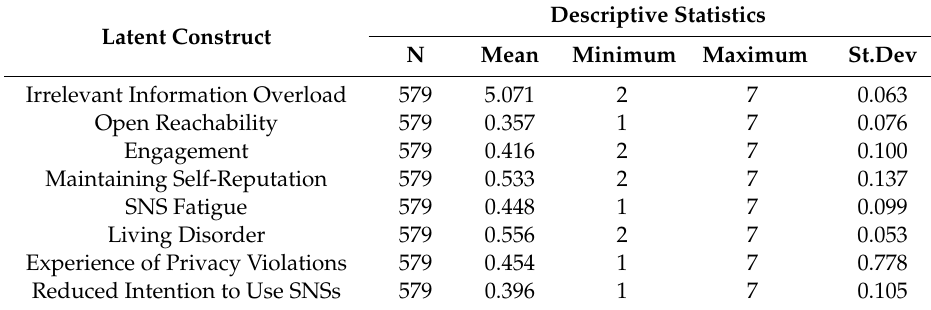
Table 3. Descriptive statistics results.